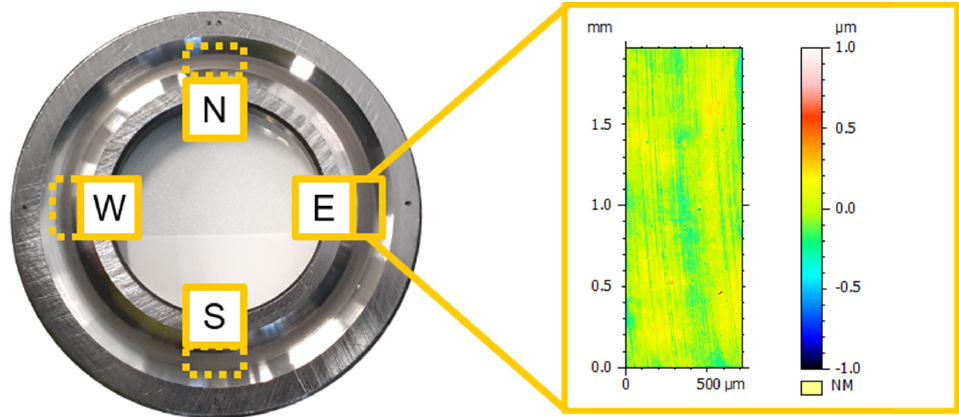
Figure 5. Damaged bearing surface with the scanned areas.